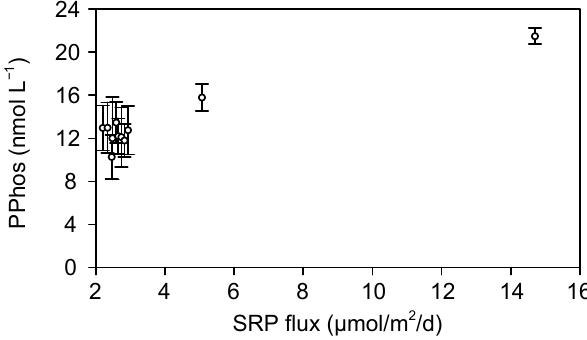
Fig. 5. PPhos as a function of vertical flux of SRP across the BV47 transect (see Fig. 1). Points represent means ± SE. PPhos was not significantly correlated with SRP flux (Spearman rank correlation, ρ =0.33,